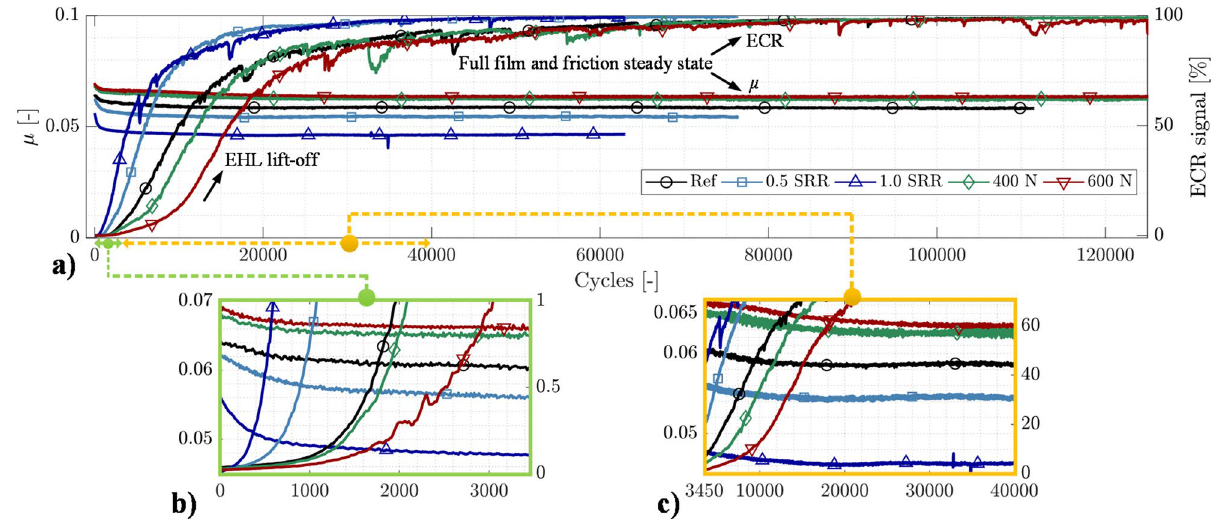
Figure 1. Ball-on-disc running-in test for hydrodynamic lift-off: ( a ) the entire test sequence showing friction and ECR traces, ( b ) 0–3500 ball rotating cycles—first friction reduction plateau with associated ECR lift (enlarged view) —and ( c ) 3450–40 000 ball rotating cycles—second running-in stage towards steady-state friction and ECR